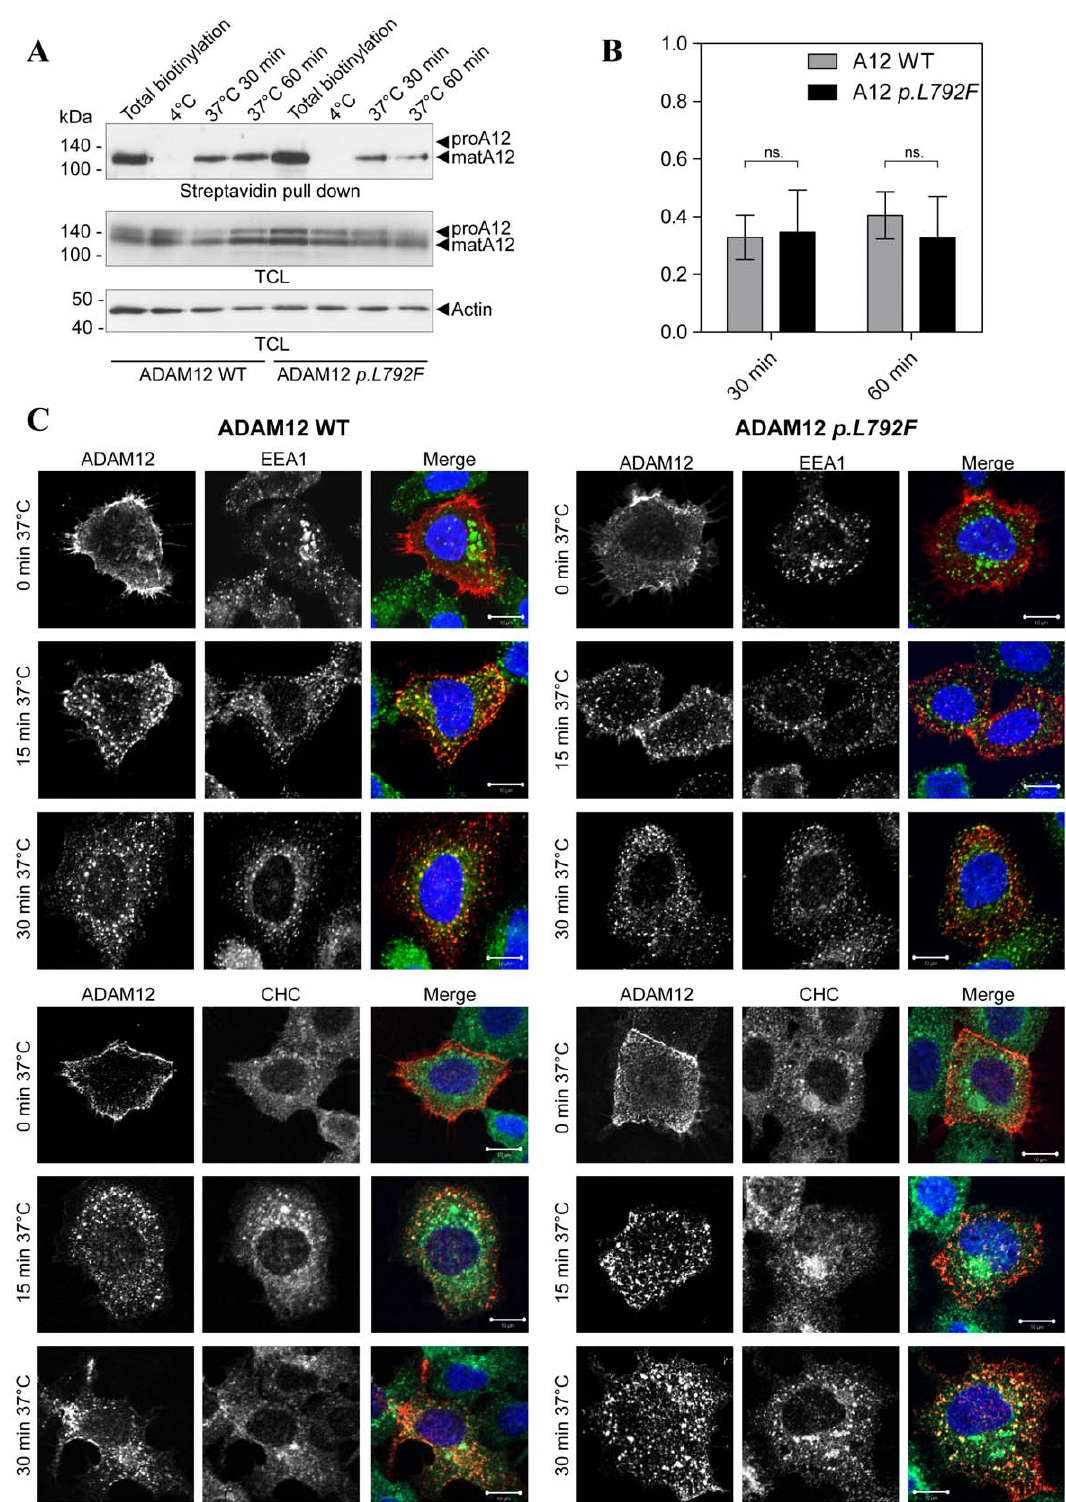
Figure 3. ADAM12 p.L792F localizes to the cell surface and is internalized similarly to wild-type ADAM12. ( A ) Biotinylation of cell surface ADAM12 WT or ADAM12 p.L792F . 293VnR cells, transiently transfected with ADAM12-GFP or ADAM12-GFP p.L792F were labeled with NHS-SS- Biotin for 30 min at 4 u C, with subsequent incubation at 4 u C (controls) or at 37 u C for indicated time points. Then, the cells were treated with reducing reagent (glutathione) to remove non-internalized biotin from the cell surface (except for total biotinylation control lane 1). The control samples kept at 4 u C were included to ensure proper removal of cell surface biotin. Biotinylated proteins were precipitated with streptavidin-conjugated agarose beads and subjected to western blotting with the appropriate antibodies. The ADAM12-GFP proform (proA12) is , 150 kDa and the mature form (matA12) is , 130 kDa. Actin was used as a loading control. TCL: Total cell lysate. ( B ) Quantitative analysis of ADAM12 internalization where